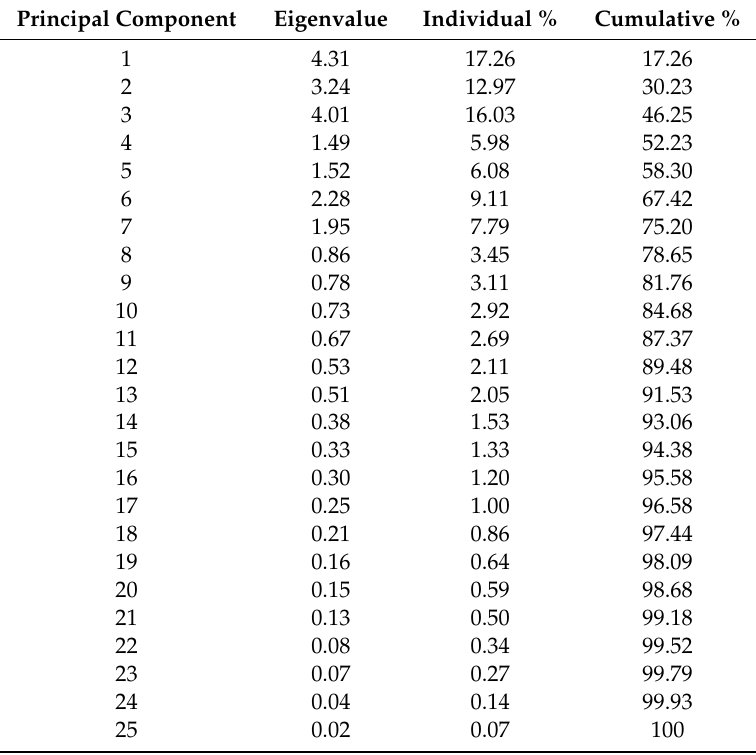
Table A1. Summary of eigenvalues of principal